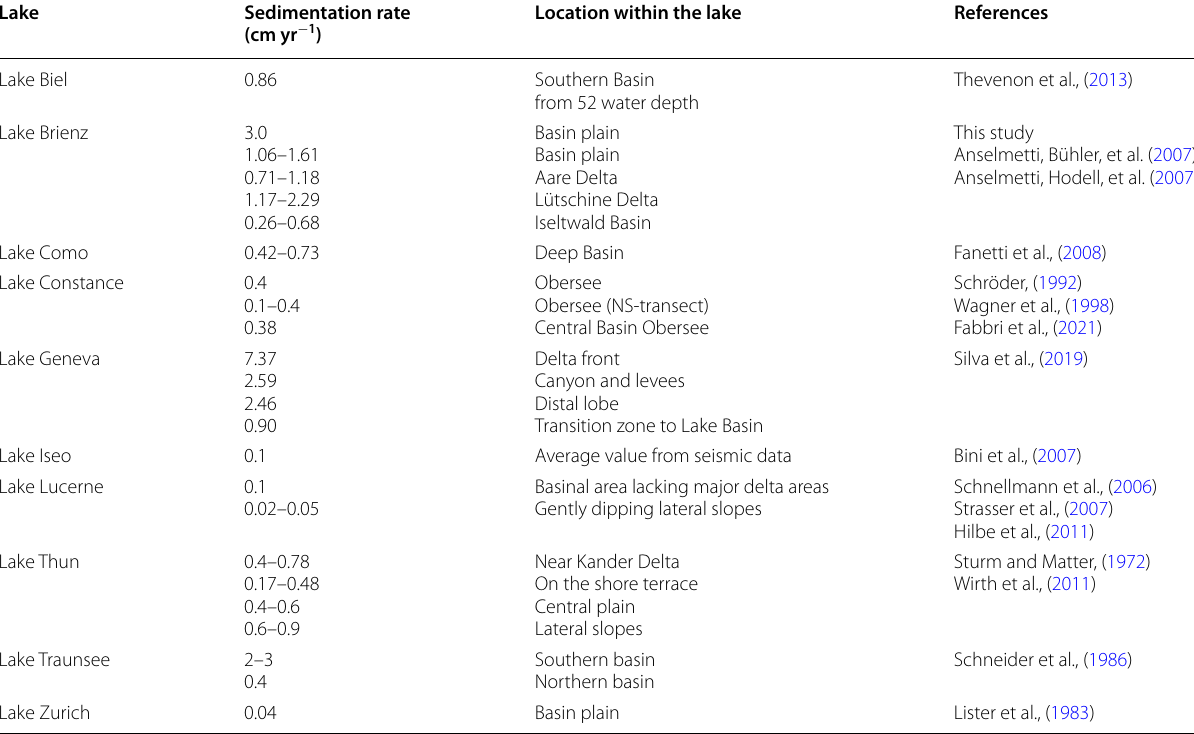
Table 4 Compilation of sedimentation rates and sediment accumulation rates in various (peri-)alpine lakes. Sedimentation rates were calculated based on different methods like cores combined with age dating, seismic data and/or bathymetric